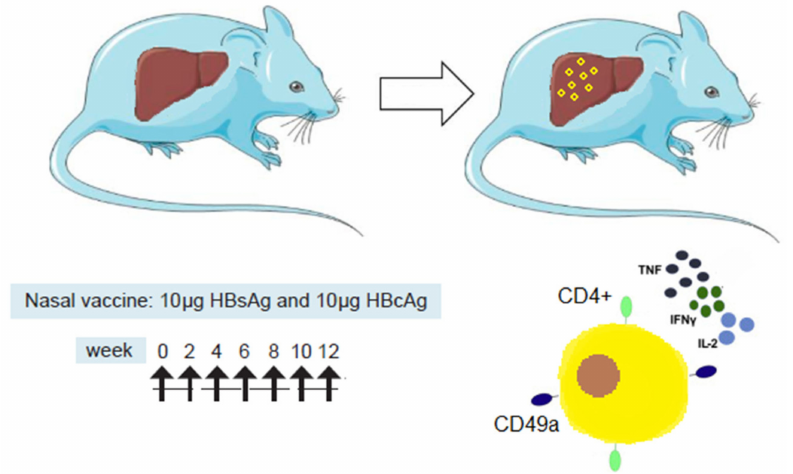
Figure 1. The i.n. route has the unique capacity to induce cellular immune responses, specifically